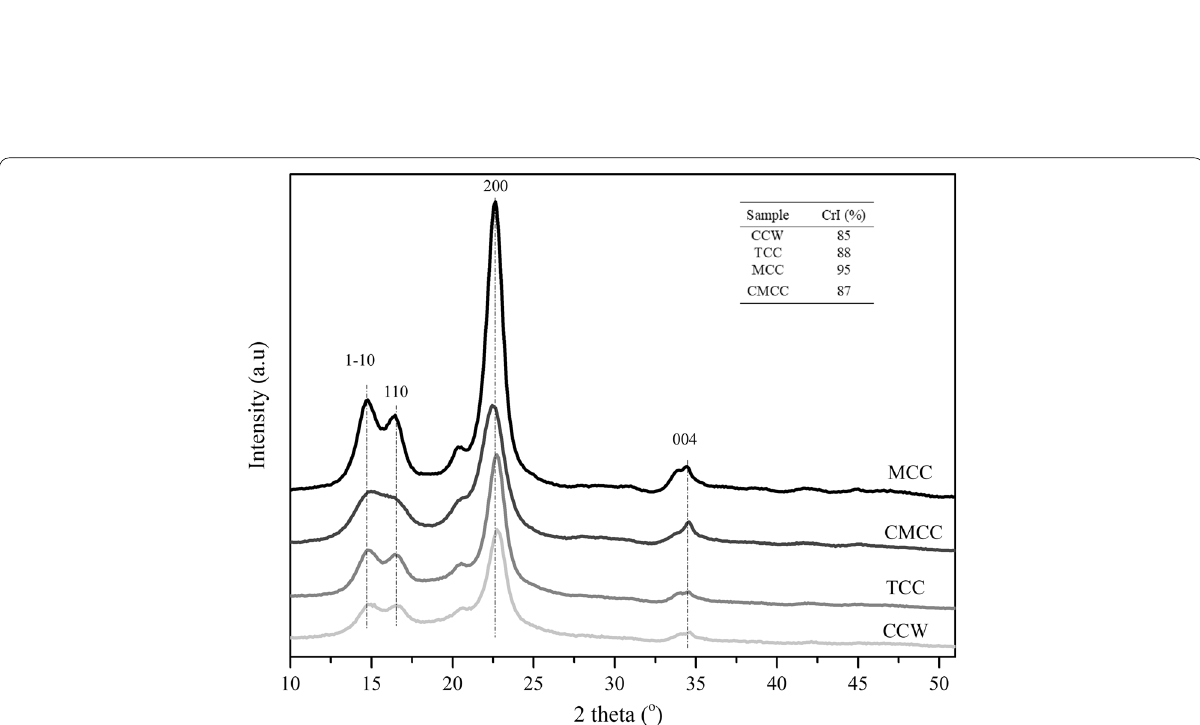
Fig. 2 X-ray diffraction patterns and crystallinity index of MCC, TCC, CCW and